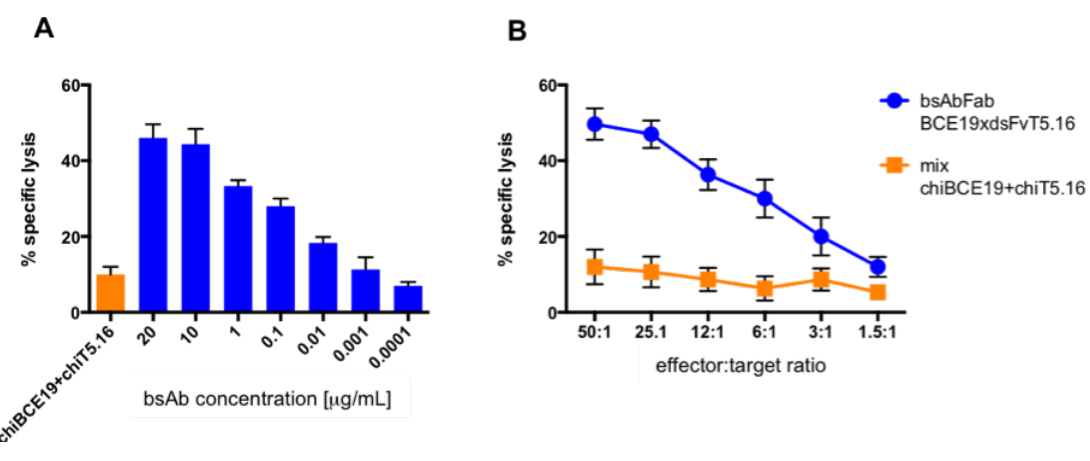
Figure 4. Cytotoxicity of activated T lymphocytes against Raji lymphoma cells by